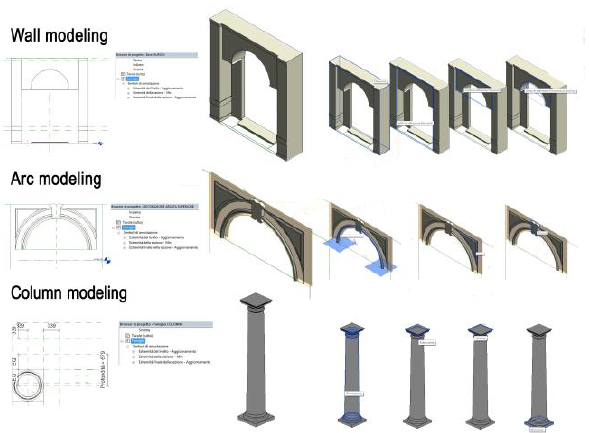
Figure 10. 3D semantic modeling of architectural subcomponents